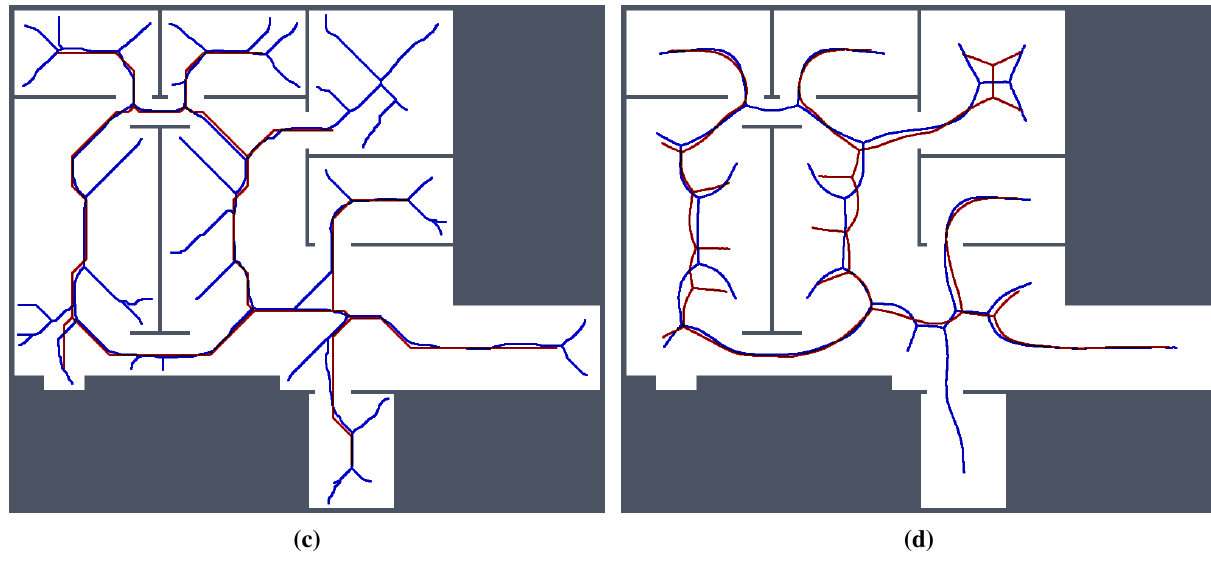
Figure 9. Determined Voronoi diagrams by the thinning and RD-based algorithms in a map = 4 and σ = 7 . The skeleton determined in noise-less of the autolab environment for σ r r map is in red while the skeleton found in the noisy map is in blue. ( a ) Thinning algorithm, σ = 4 ; ( b ) RD-based algorithm, σ = 4 ; ( c ) Thinning algorithm, σ r r = 7 algorithm, σ r